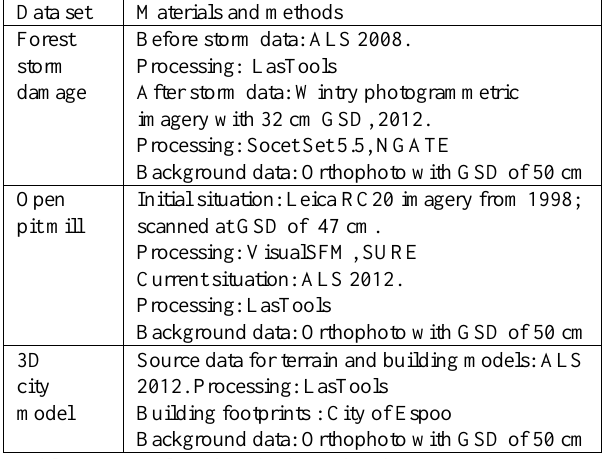
Table 1. Materials and methods used in the case